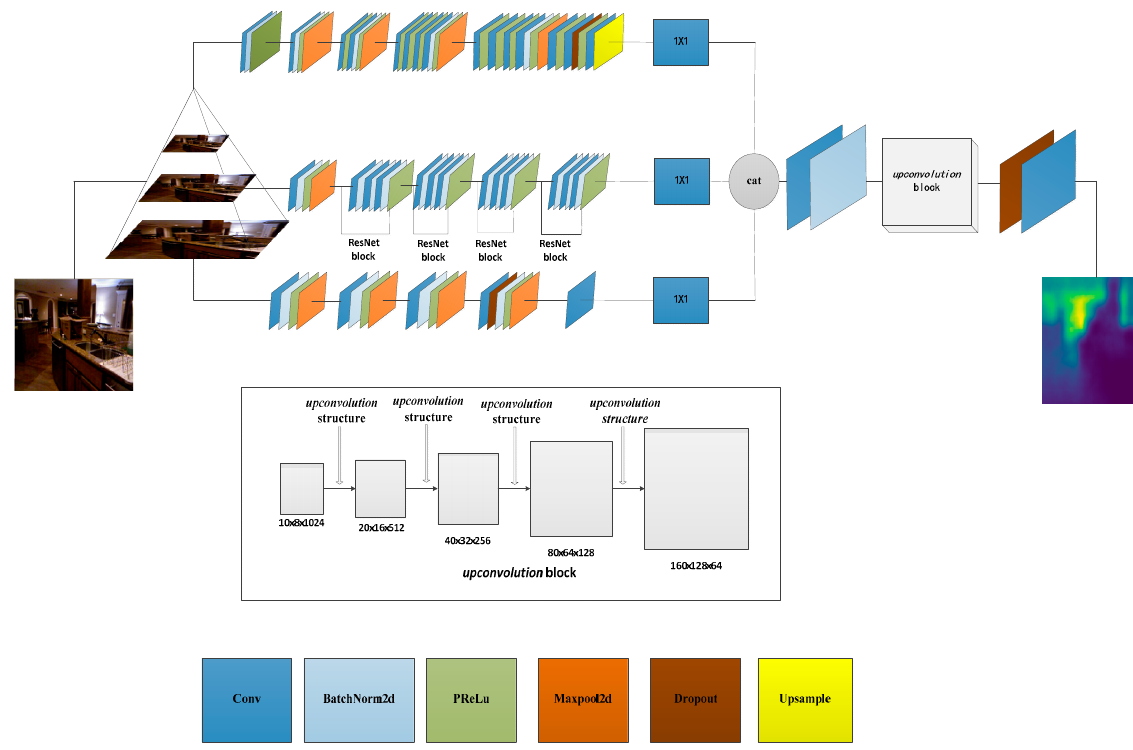
Figure 1. Our three-streamed depth estimation network architecture. Each stream extracts image features at different scales. We used six colors to represent the different operation modules (convolution, normalization, activation, pooling, dropout and upsampling). Cubes are upconvolution blocks in gray, which are composed of four upconvolution structures (see Figure 2) .